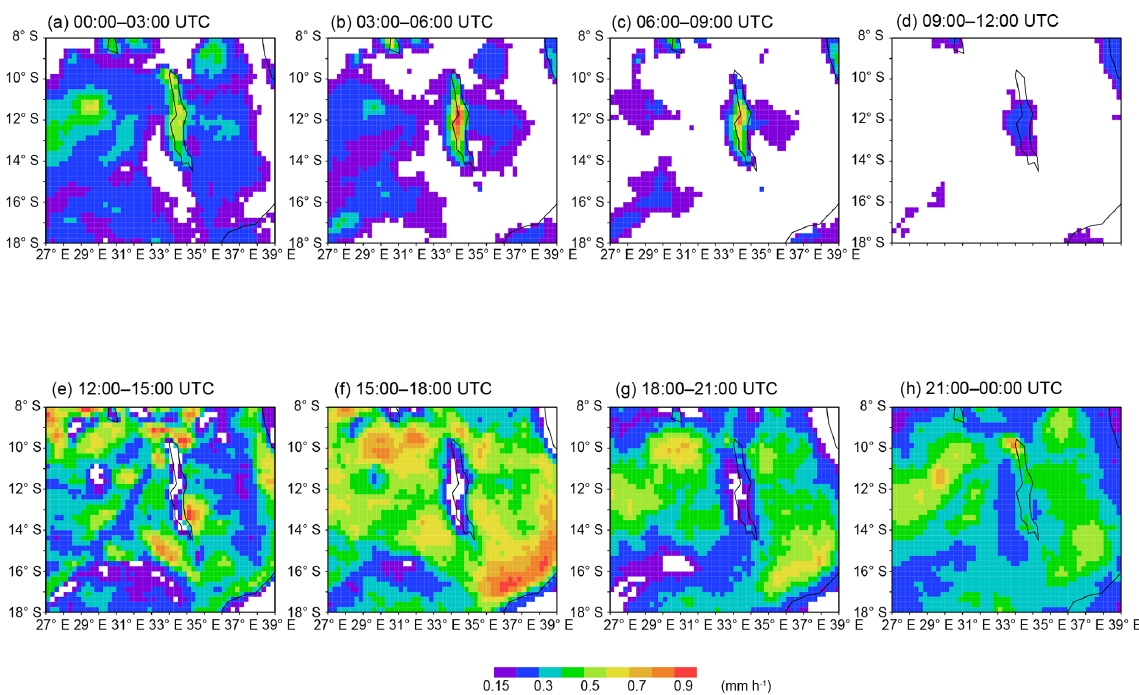
Figure 2. Climatological 3-hourly precipitation of TRMM 3B42 in NDJFM (1998–2012). The white colour is precipitation less than 0.15mmh − 1